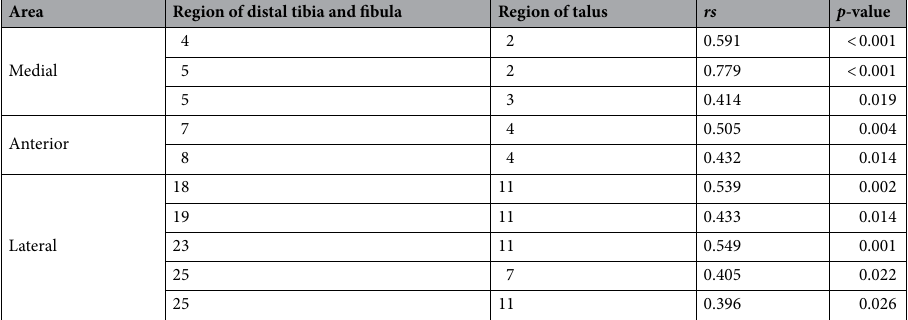
(Fig. 5). The mean amounts of surface elevation on the anterior borders of the lateral malleolus and the distal tibiofibular joint were approximately 1 to 2 mm in varus ankle OA with stage 3b and 4 (regions 18, 19, 23, and 25) (Figs. 4, 5). On the other hand, the mean left–right surface differences in the control group were < 0.4 mm, indicating the above-mentioned surface deviations occurred due to varus ankle OA. Table 2 shows the correlations of the surface deviations on the tibia and fibula with the corresponding surface deviations on the talus (See “Methods” section). It was found that the surface depressions on the articular surface of the medial malleolus (regions 4 and 5) were significantly correlated with the surface depressions on the medial margin of the talar trochlea (regions 2 in Seki et al. 8 ). Furthermore, there was a significant correlation between the surface elevations on the anterior apophysis of the distal tibia (regions 7 and 8) and the anterior margin of the talar trochlea (region 4 in Seki et al. 8 ). In addition, the surface elevations on the anterior edge and articular surface of the lateral malleolus (region 18, 19, and 21) and the anterior edge of the distal tibiofibular articular surface (region 23 and 25) were significantly correlated with the surface elevation on the lateral articular surface of the talus (region 11 in Seki et al. 8 ).